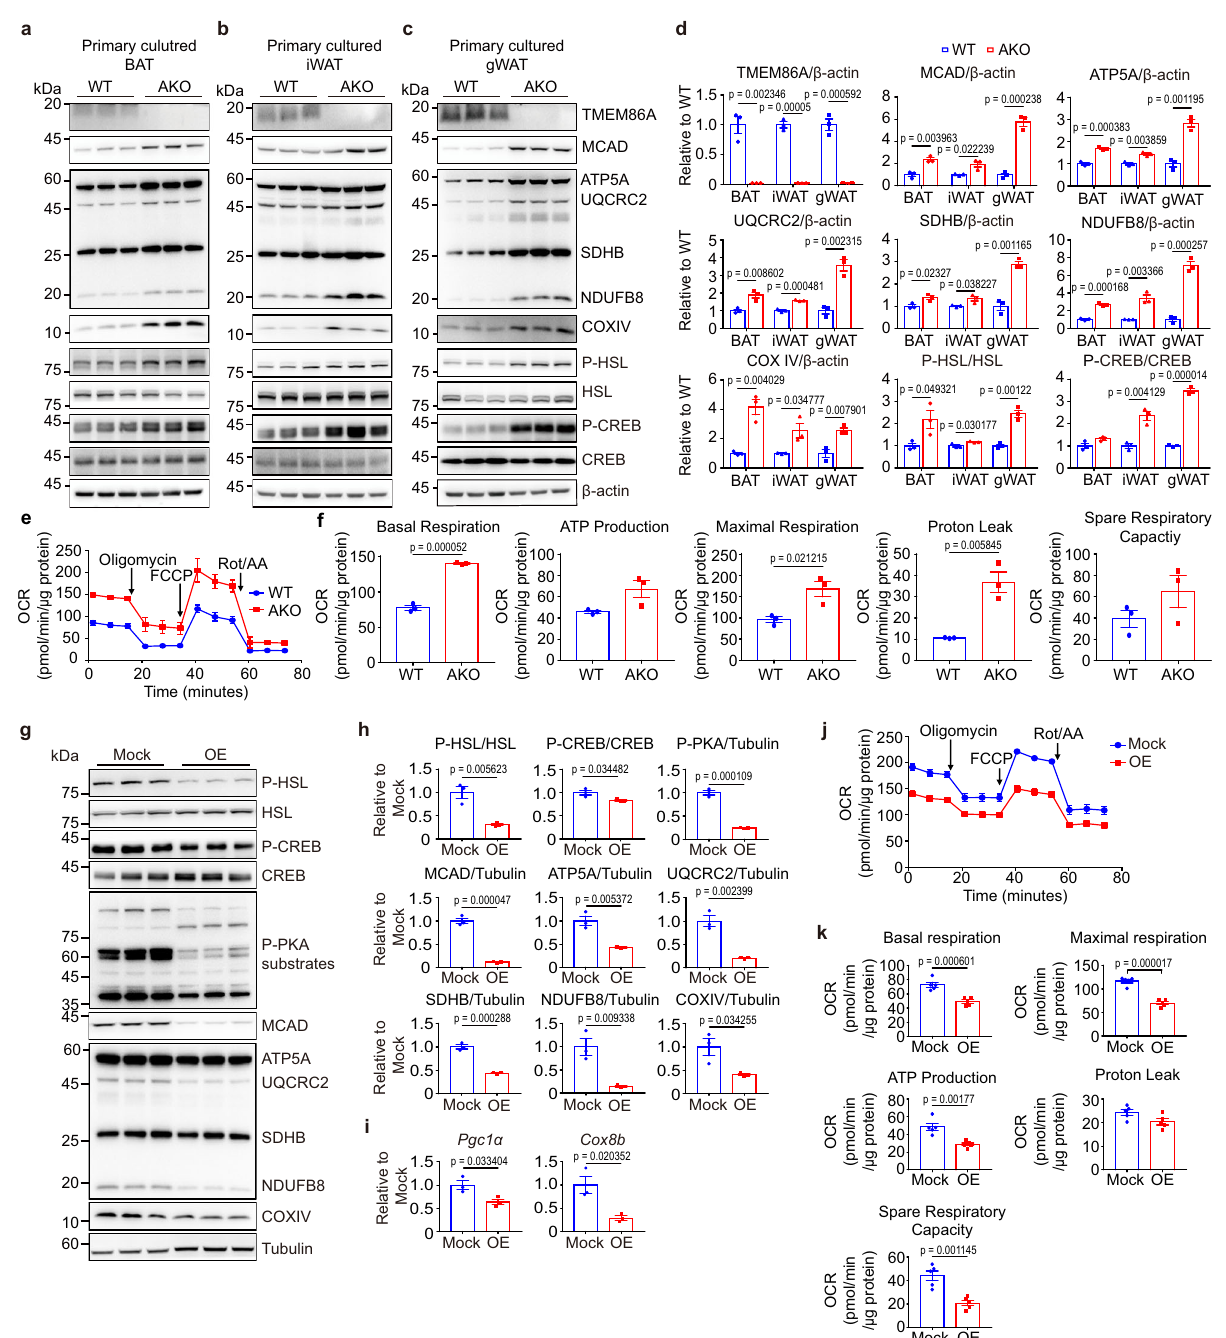
Fig. 5 In vitro modulation of TMEM86A expression regulated PKA signalling pathway and mitochondrial oxidative metabolism of adipocytes. a – d Immunoblot analysis of adipocytes differentiated from precursors obtained from BAT, iWAT and gWAT of WT and TMEM86A AKO mice. n = 3. e , f Oxygen consumption rate measurement of adipocytes differentiated from precursors obtained from gWAT of WT and TMEM86A AKO mice. n = 3. g – i Immunoblot and qPCR analyses of TMEM86A overexpression effects in C3H10T1/2 adipocytes. n = 3. j , k Oxygen consumption rate of TMEM86A overexpressing C3H10T1/2 adipocytes or controls. n = 5. Each point represents a biological replicate. Data are presented as the mean ± SEM. Statistical signi fi cance was determined by the unpaired, two-tailed t -test in d – f , h – i , and k . Source data are provided as a Source Data fi